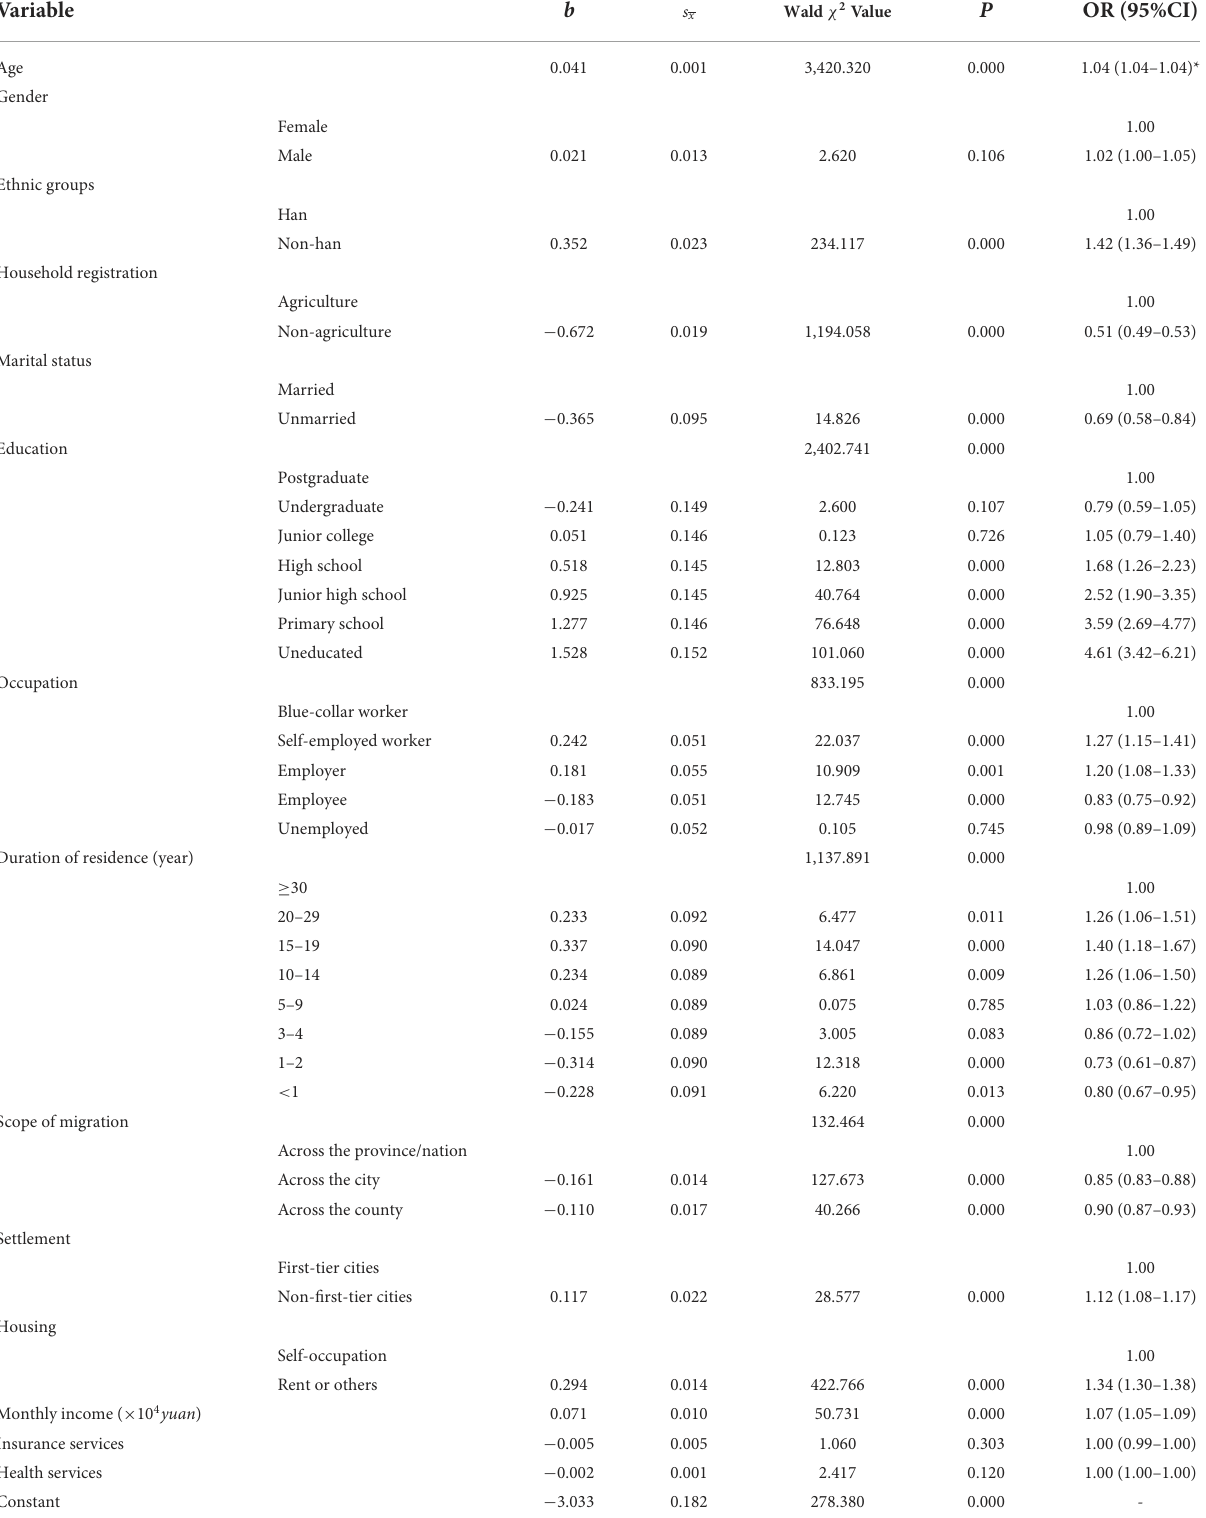
TABLE 5 Associated factors of the two-children fertility behaviors of floating